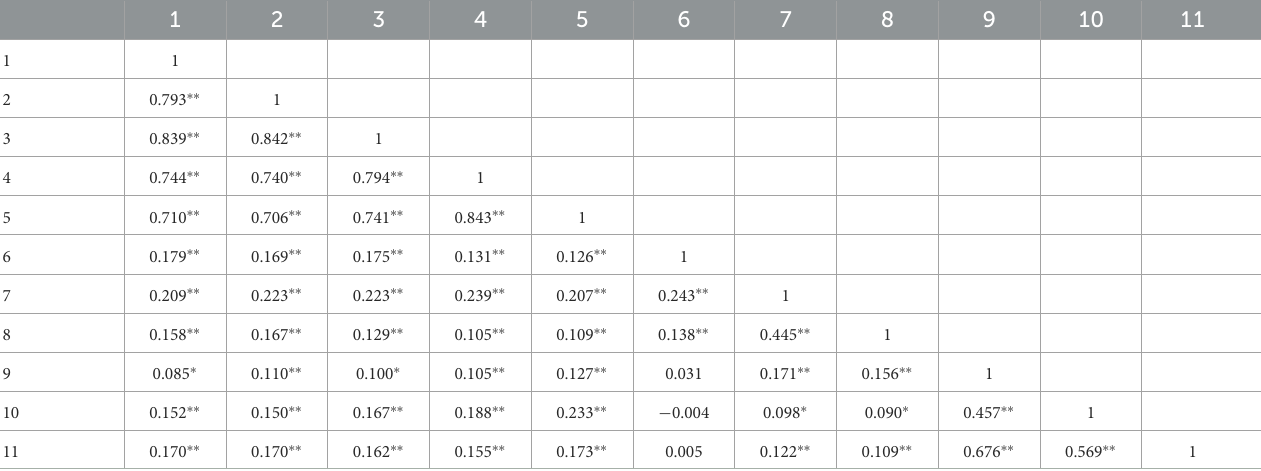
TABLE 2 The correlation matrix analysis between social support, self-reported oral health, and life satisfaction.